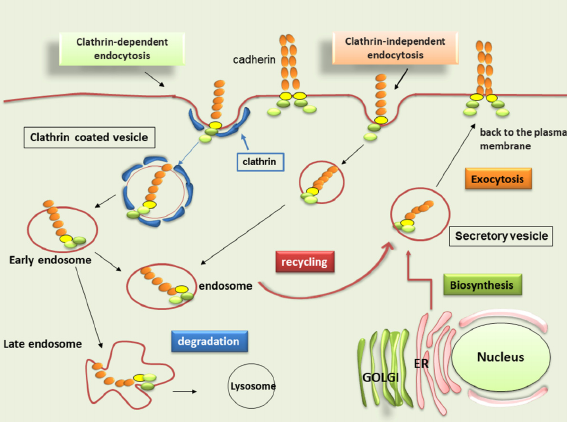
Figure 2. Classic pathways of cadherin trafficking. Cadherins can undergo either clathrin-depend- ent or independent endocytosis. Trafficking of internalized cadherins occurs through several endo- somal compartments. Numerous molecules and endocytic machinery determine the fate of cadher- ins. After internalization, cadherins are transferred to early endosomes, from which they can be recycled back to the plasma membrane or delivered to late endosomes and lysosomes for degrada- tion. 2.3. Physiological Role of Epithelial and Vascular-Endothelial Cadherins Adherens junctions and desmosomes are two intercellular junctions that maintain the integrity of the epidermis, controlling the differentiation and proliferation of keratino- cytes. Classic cadherins mediate specific adhesion at the intercellular adherens junction. They share high sequence homology in their ectodomain with desmosomal cadherins [21– 23]. E-cadherin and placental (P)-cadherin are classic epidermal cadherins. As to E-cad- herin, it has been reported to be widely distributed in all skin layers and skin appendages, and its role in keratinocytes-melanocytes adhesion and communication has been estab- lished. The expression of P-cadherin, indispensable for skin and eye function, is more di- versified and dependent on the skin layer. It is abundant in the basal and lower suprabasal layers, where it was shown to be linked with the proliferative cell compartment of the epidermis [24]. Desmosomal cadherins comprise two separate subfamilies, the Desmocol- lins (DSC, − 1, − 2, − 3) and Desmogleins (DSG, 1, − 2, − 3, − 4), all encoded by separate genes [22]. The expression of different members of the desmosomal cadherins presents a tissue- dependent temporal and spatial transcription [22]. The expression of the “skin type” des- mosomal cadherins, Dsc1 and Dsg1, was correlated with the morphological features of keratinocyte terminal differentiation in the epidermis; they are expressed throughout the epidermis but most prominently in the upper layers. Dsg1 and Dsc1 expression decrease closer to deeper layers, whereas Dsg3 and Dsc3 are in most cases discovered within the basal layer and show an inverse expression gradient, reducing steadily in the parts closer to the top layers [25]. Dsg1/Dsg3 and Dsc1/Dsc3 are restricted to certain specialized, mostly stratified squamous epithelia, whereas Dsg2 and Dsc2 are the most ubiquitously expressed isoforms in desmosome-bearing tissues [26]. Furthermore, in the human epi- dermis, Dsg3 expression is detected from the basal to the spinous layers, whereas Dsg2 expression is limited to the basal cell layer [27]. Recently, a fourth member of the desmoglein family, Dsg4, was identified, which is expressed in the suprabasal layers of